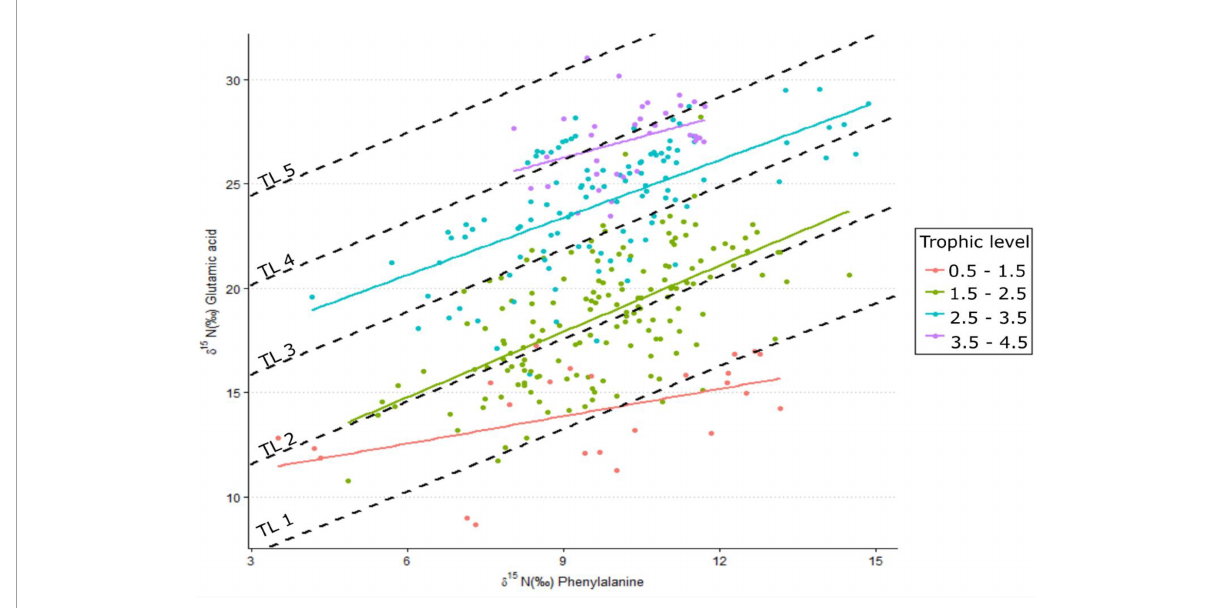
FIGURE2 δ 15 N values for the amino acids glutamic acid and phenylalanine measured for species across different trophic levels. Dashed lines are expected linear relationships for trophic levels 1–5 using a trophic discrimination factor of 4.9% and a β of 4.3%, while colored linear regressions are trophic-level relationships by grouping trophic levels across species ( n = 24–166).